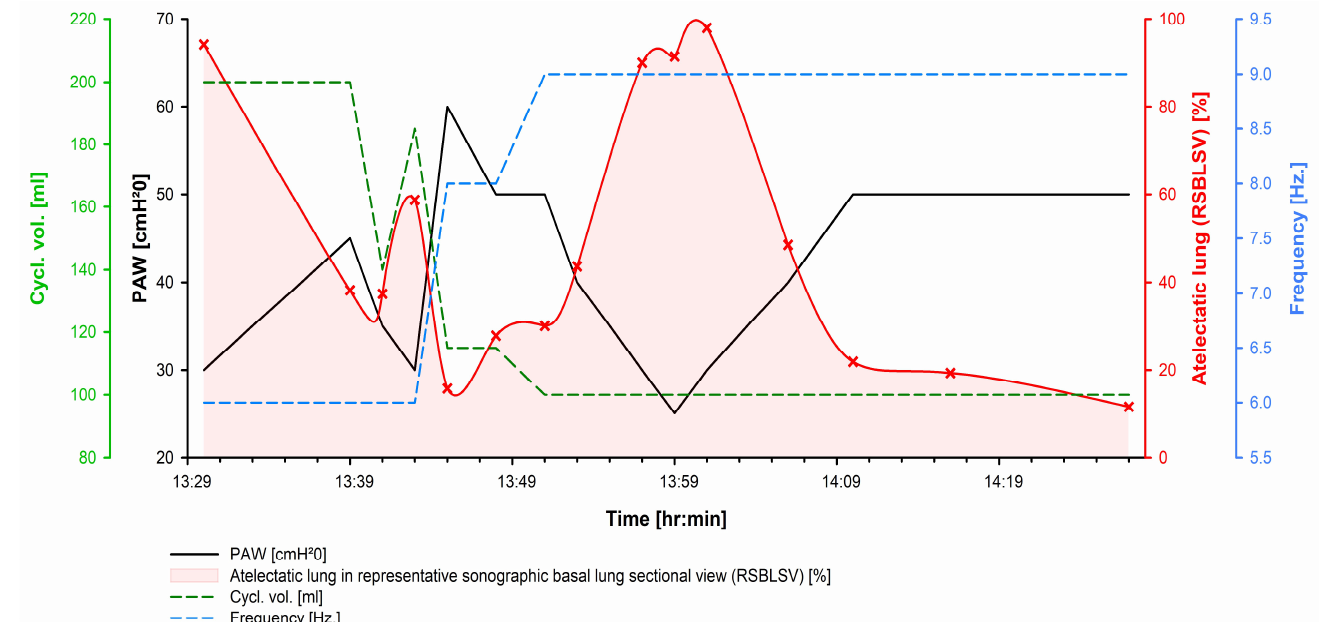
Figure 2. Atelectatic lung area during high-frequency oscillatory ventilation in patient #2. Cycle-volume, positive airway pressure, and the frequency of high-frequency oscillatory ventilation (HFOV) in relation to the atelectatic lung area (red, red shaded) estimated by lung sonography. An experimental HFOV pressure trial was performed over a duration of 30 min to reduce the atelectatic lung area and, consecutively, improve oxygenation. Time scale [hr:mm], Middle European Time (MET). Table 1. Assist device use, vasopressor therapy, and haemodynamic values in patient #2.